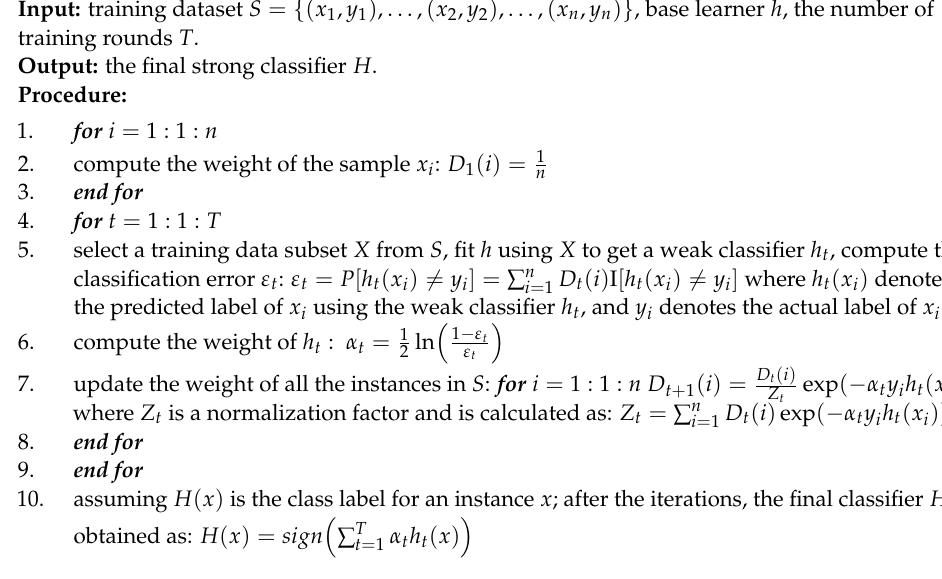
Algorithm 1: Conventional AdaBoost